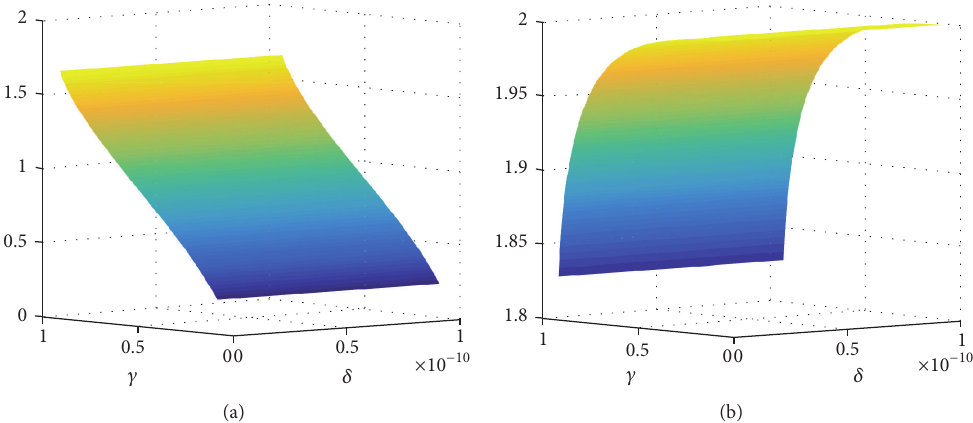
Figure 5: In this figure, we plot (a) |𝑔 𝛿 (𝑝 1 𝛾 ;𝛾)|/𝛿 and (b) |𝑔 𝛿 (𝑝 2 𝛾 ; 𝛾)|/𝛿 over the range 10 −12 ≤ 𝛿 ≤ 10 −10 and 0.1𝛾 ∗ ≤ 𝛾 ≤ 0.99𝛾 ∗ .